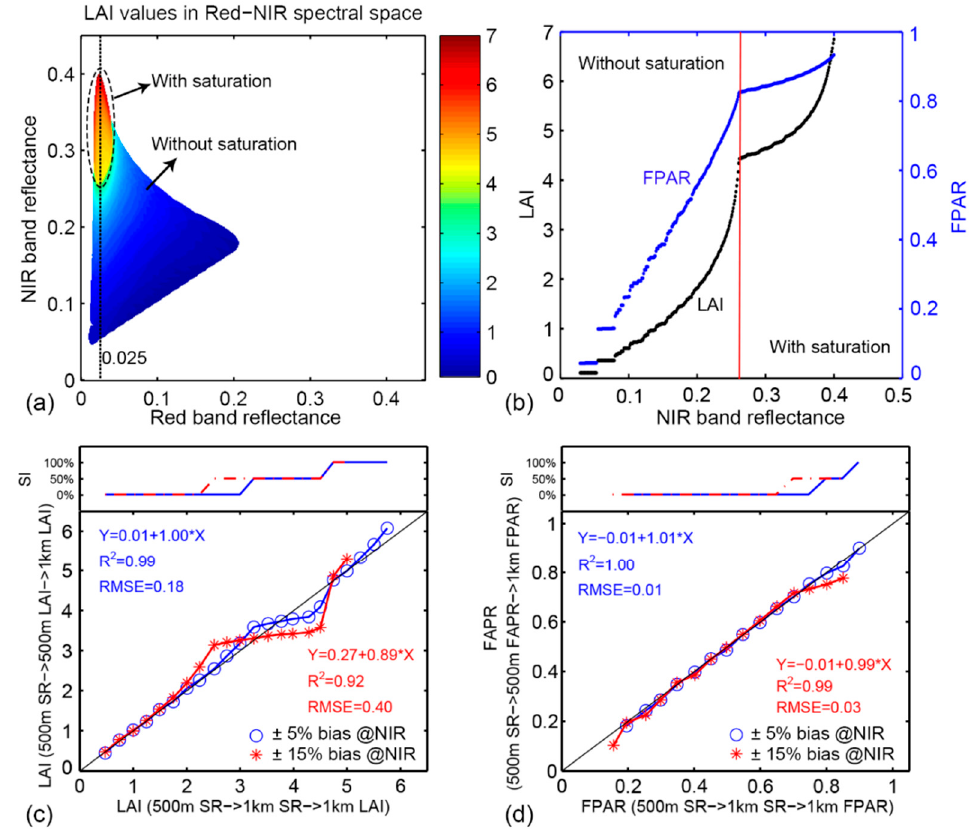
Figure 10. Scale effect of MODIS LAI/FPAR main algorithm. Biome 6 (deciduous broadleaf forests) is used as an example here. The solar zenith angle is fixed at 30° and the view direction is nadir. ( a ) Distribution of LAI values derived from the main RT based algorithm in the Red-NIR spectral space. Equally spaced LAI values along the vertical black line (red = 0.025) are selected as experimental retrievals from C5 (LAIc5). The corresponding reflectances of C5 are REDc5 and NIRc5. Let the red reflectance of all the four C6 pixels (REDc6) be equal to REDc5. To satisfy the energy conservation law, we add a positive bias to NIRc5 to obtain NIRc6_1 for two C6 pixels and add a negative bias to NIRc5 to obtain NIRc6_2 for the two left C6 pixels. Thus, four C6 LAIs can be derived using REDc6 and NIRc6. ( b ) Denotes the variations of LAI (black points) and FPAR (blue points) with NIR reflectance along the black line in ( a ). Retrievals with and without saturation are separated by a red line. ( c ) and ( d ) demonstrate the discrepancy in LAI and FPAR caused by scale effects, respectively. 5% and 15% bias are shown in blue and red. The saturation index (SI) for different LAI (FPAR) values is also plotted in the figures.